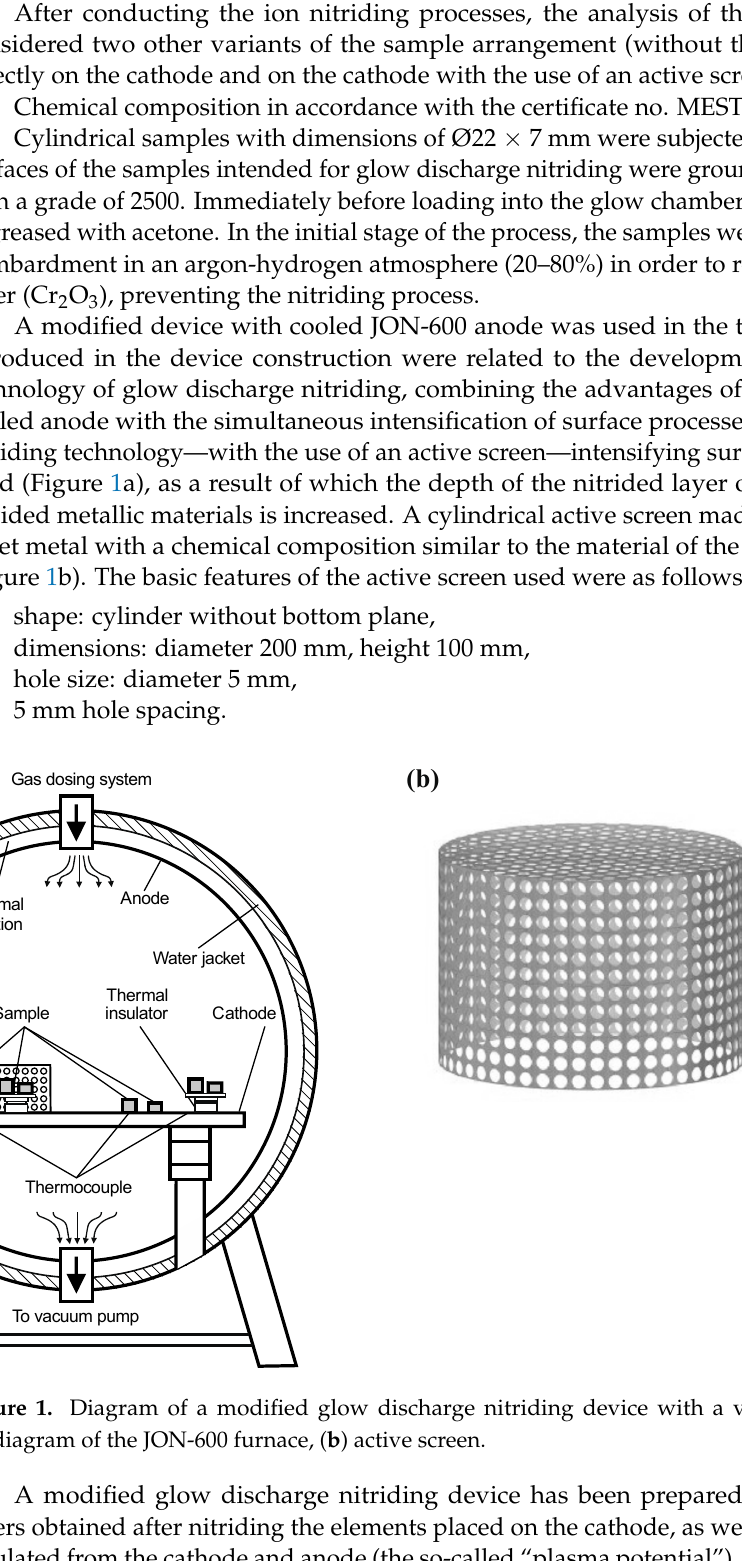
Table 1. Chemical composition of 316L austenitic steel, % wt.